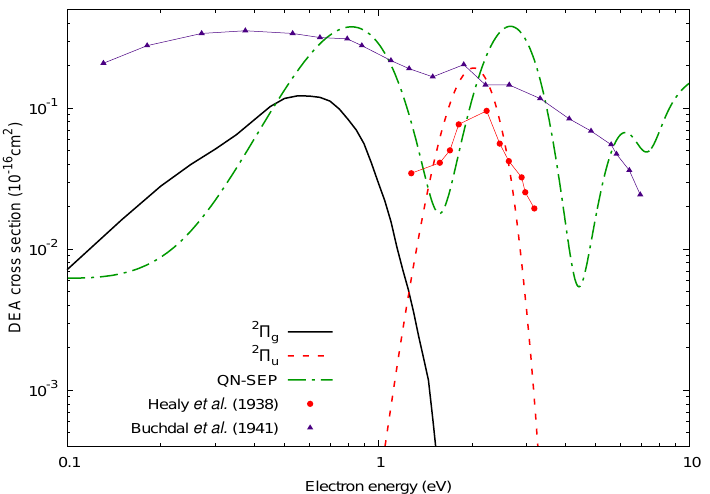
Figure 5. DEA cross section of I 2 . In the LCP framework (solid and dashed lines), the cross section shows maxima at 0.6 and 2 eV similar to Buchdal et al. [28]. The results from Healy et al. [29] agree with the 2 Π u resonance position. QN’s SEP calculations (dashed-dotted line) exhibit the same structures with shifted peaks compared to the present results.